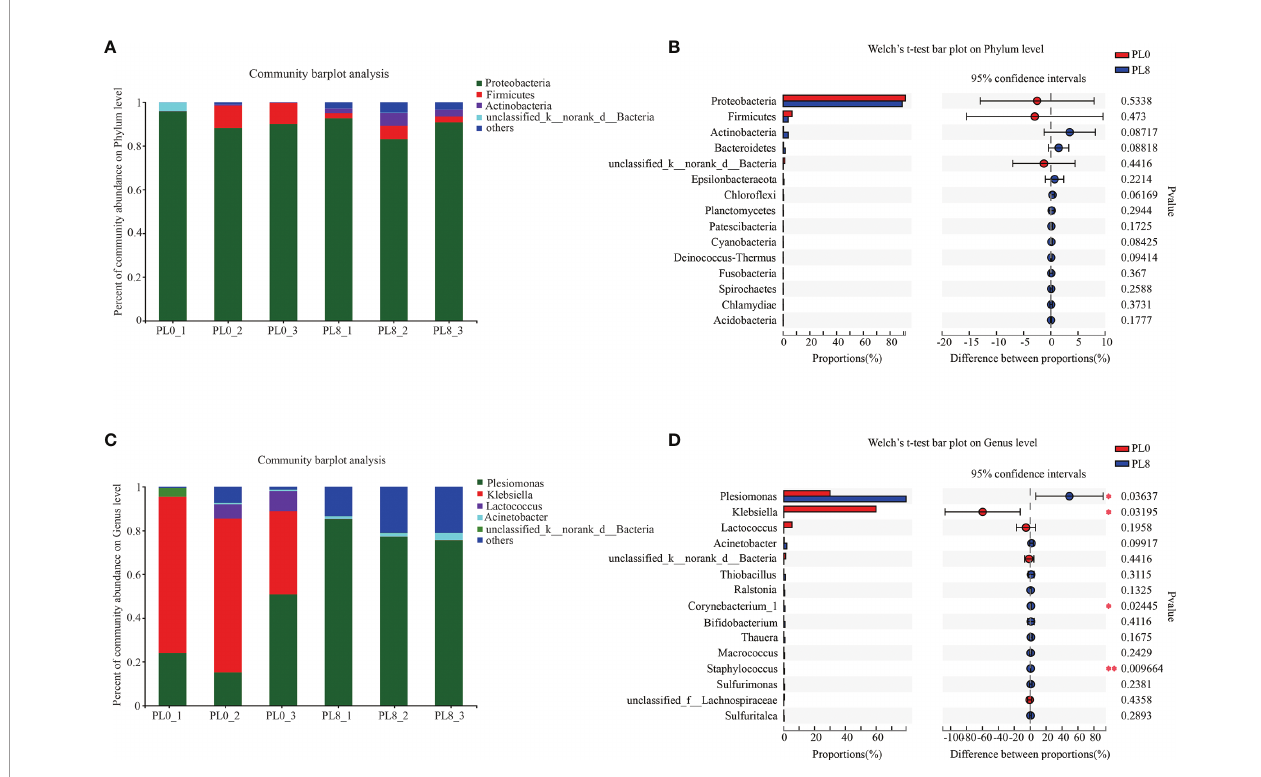
FIGURE 8 | Relative abundances (%) of bacteria and comparison of bacterial abundances in the intestine of largemouth bass in the PL0 (control) and PL8 groups. at the phylum (A, B) and genus (C, D) level, and the phyla and genus with relative abundances lower than 1% were assigned as “ others ” , respectively. ⁎ 0.01 < P